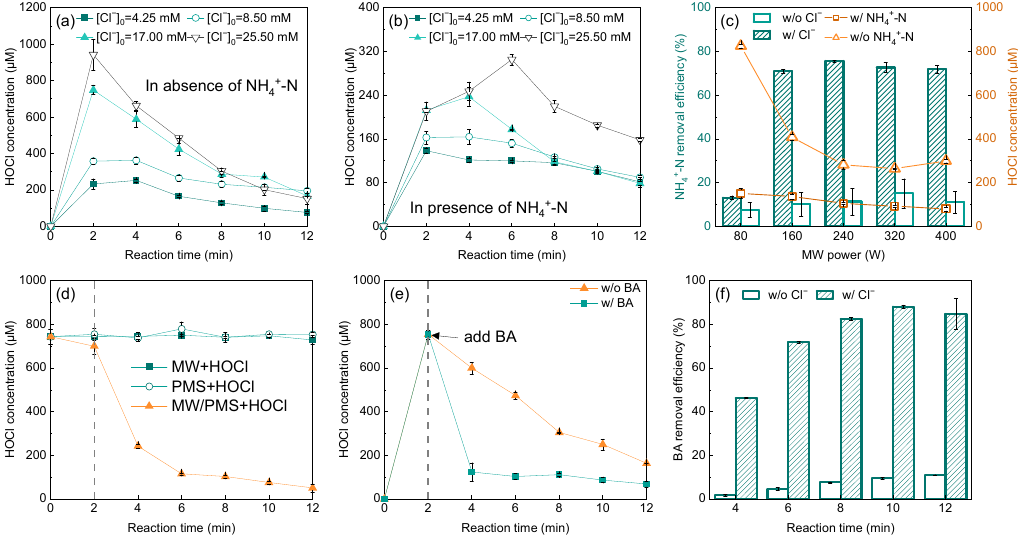
Figure 3. Effects of ( a , b ) Cl − and ( c ) MW power on cumulative HOCl concentration in the MW/PMS system in absence and presence of NH 4+ -N. ( d ) Variation of HOCl concentration in MW-alone, PMS-alone, and MW/PMS systems when the HOCl initial concentration was 750.00 ± 5 μM in the absence of NH 4+ -N. ( e ) Effects of benzoic acid (BA) on cumulative HOCl concentration in the MW/PMS system. ( f ) Effects of Cl − on the BA removal efficiency in the MW/PMS system. Reaction conditions: MW power = 160 W, [PMS] 0 = 10 mM, [Cl − ] 0 = 17.00 mM, [HOCl] = 750.00 ± 5 μM, [NH 4+ -N] 0 = 60 mg/L, [BA] 0 = 1 mM, and reaction time = 8 min.